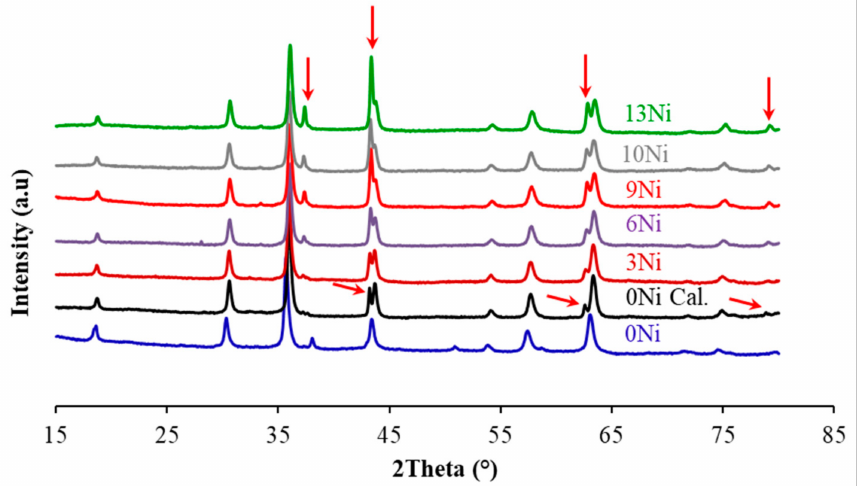
Figure 2. XRD of catalysts as a function of Ni